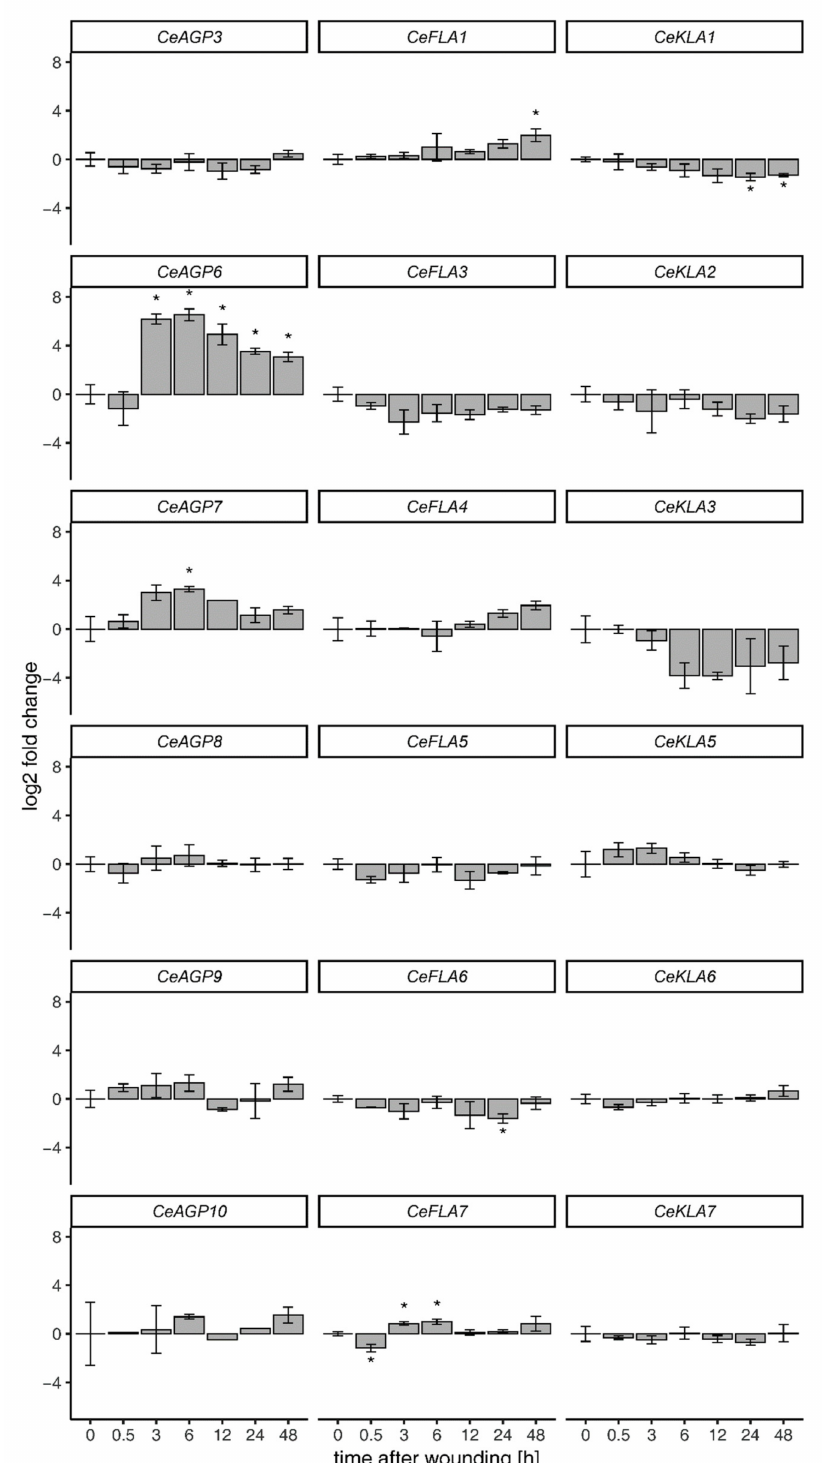
Figure 6. Temporal gene expression profiles for the 18 studied AGp, FLA and KLA genes obtained after cutting of leaf explants. Mean and standard deviation is shown for three biological replicates. Immediately frozen tissue after wounding (0 min) was used as control sample. Asterisks indicate significant difference obtained via Student’s t -test between a specific time point and the appropriate control sample. Multiple comparison correction was performed jointly for all performed comparisons using the Benjamini and Holcberg